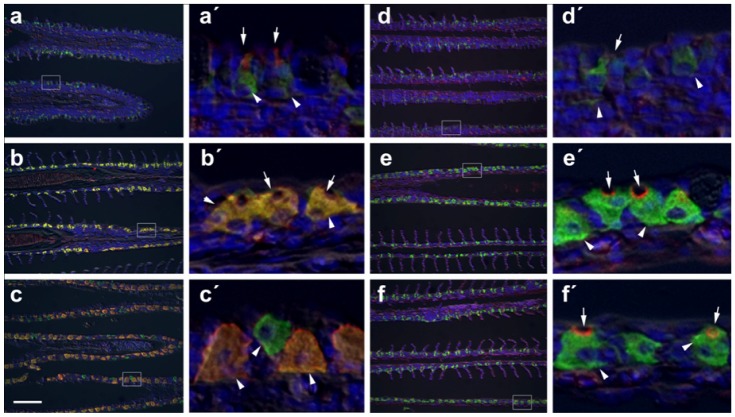
Immunohistochemical localization of transporters in gills of tilapia acclimated to different salinities.Representative micrographs of immunohistolocalization of Nka (green) with either Nkcc/Ncc (a–c; red) or Cftr (d–f; red) in the gills of tilapia acclimated to FW (a,d), SW (b,e) or HSW (c,f). Co-localization of red and green fluorochromes results in yellow-orange staining. Higher magnification (10×) of boxed areas in (a–f) correspond to panels (a′–f′). Sections are counter stained with the nuclear stain DAPI and overlaid with the DIC image for tissue orientation. Arrows indicate apical staining and arrowheads tubular system (basolateral) staining. Scale bar 100 µm (a–f), 10 µm (a′–c′).